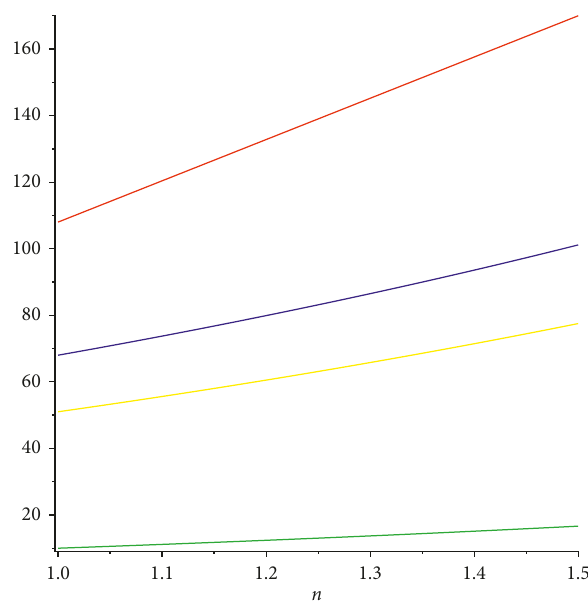
P n n , PETIM, DPZ n , and PETAA.